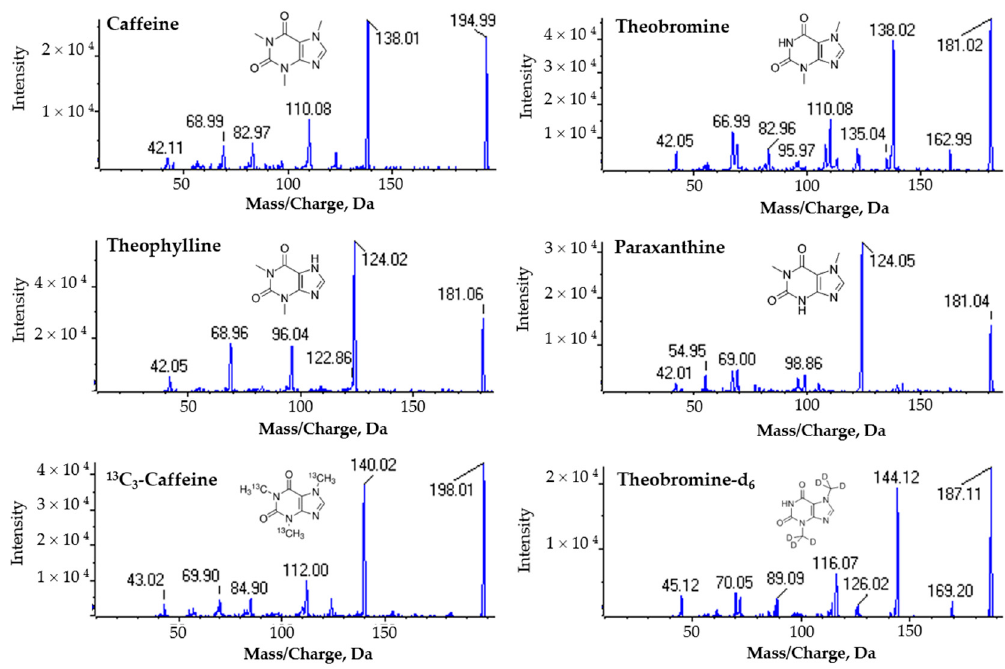
Figure 1. Fragmentation mass spectra by collision-induced dissociation (CID) of ca ff eine, theobromine, theophylline, paraxanthine and the internal standards 13 C 3 -ca ff eine and theobromine-d 6 . Standard solutionsweredirectlyinfusedintothemassspectrometerinpositiveionizationmodeandfragmentation was performed with a collision energy ramping. The presented fragmentation mass spectra are the combination of fragmentation data acquired for collision energies between 20–45